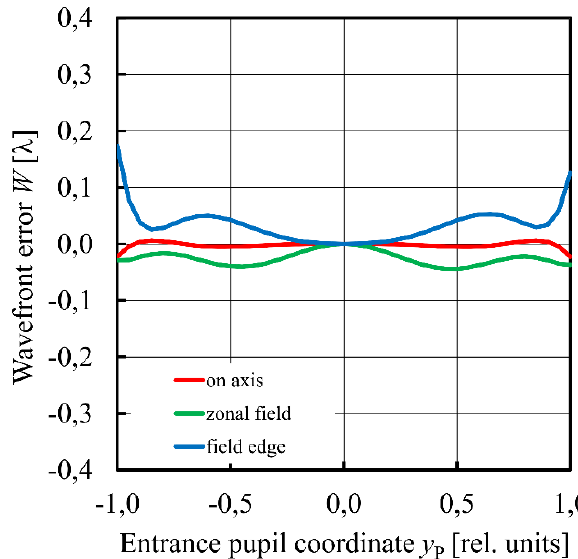
Fig. 3. Wavefront aberration W in meridional direction ( (cid:4) = 0(cid:10) of the initial system given in Fig. 2(a) for three object heights h = 0.0 mm (on axis, red), h = 3.54 mm (zonal, green) and h = 5.0 mm (field edge, blue).